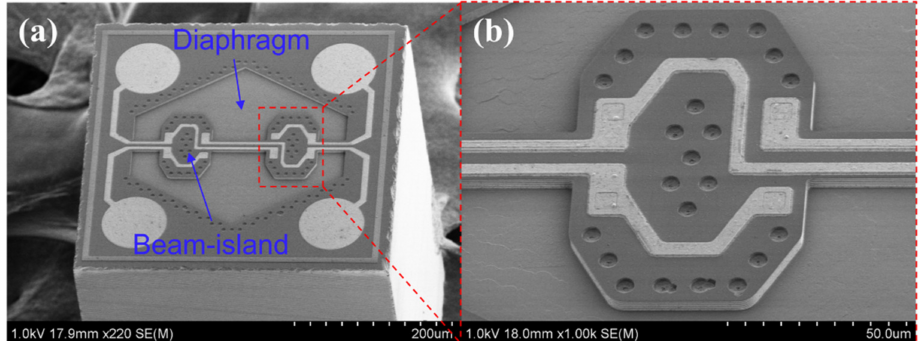
Figure 2. MEMS pressure sensor (0.4 mm × 0.4 mm). ( a ) Scanning electron microscopy image of the MEMS pressure sensor. ( b ) Close-up view of the beam-island structure. (Reproduced with permission from Ref. [43] provided by IOP Publishing, Ltd, United Kingdom of Great Britainand Northern